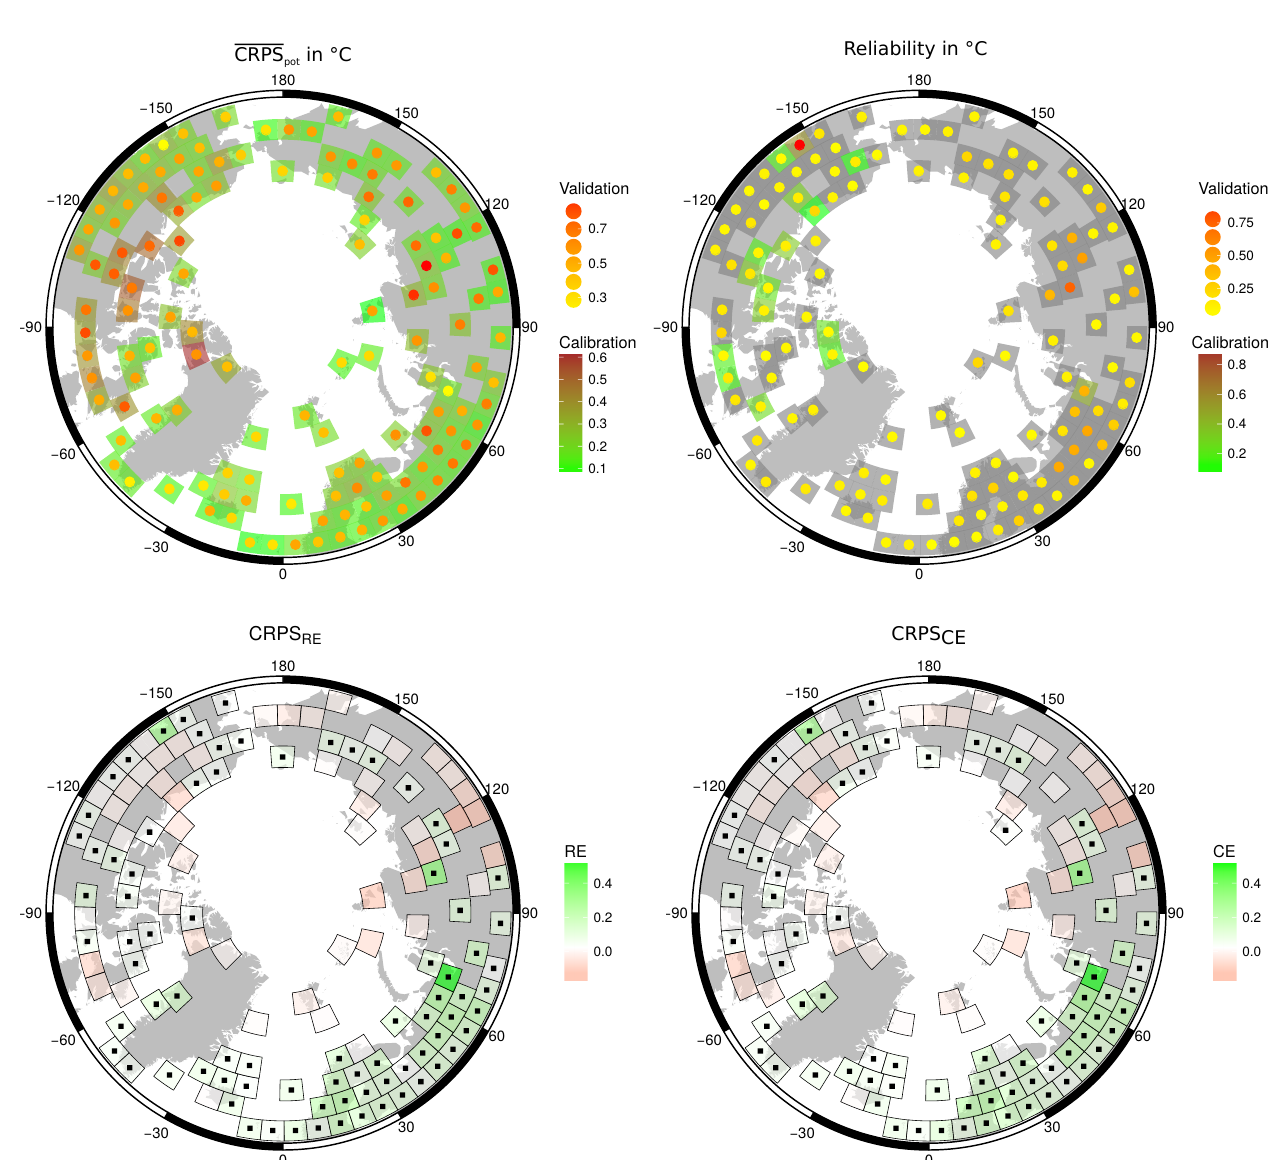
Figure A1. Calibration and validation results. The top row shows the CRPS pot and reliability score for the calibration (quadrilaterals) and validation (points) periods. The bottom row shows the CRPS scores corresponding to an ensemble-based version of the reduction of error (RE) and coefficient of efficiency (CE) estimates. Squares denote grid cells with positive CRPS-RE or CRPS-CE, indicating a skilful reconstruction in the validation period. Grid cells with few data in the validation period show a lack of skill, which might be an